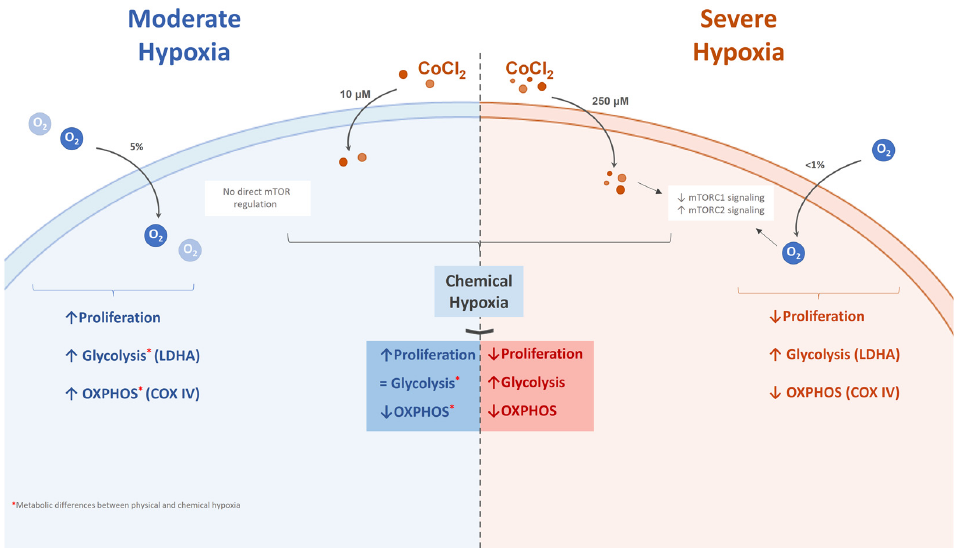
Figure 4. Effects of the different hypoxia conditions on UC-MSC behavior described in this work.